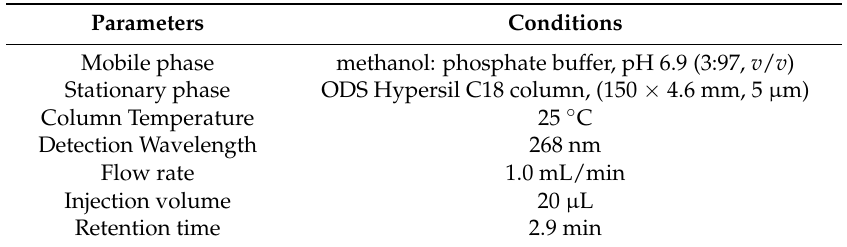
Table 2. Optimized chromatographic conditions for determination of released amount of 5-FU from mesoporous silica SBA-15.